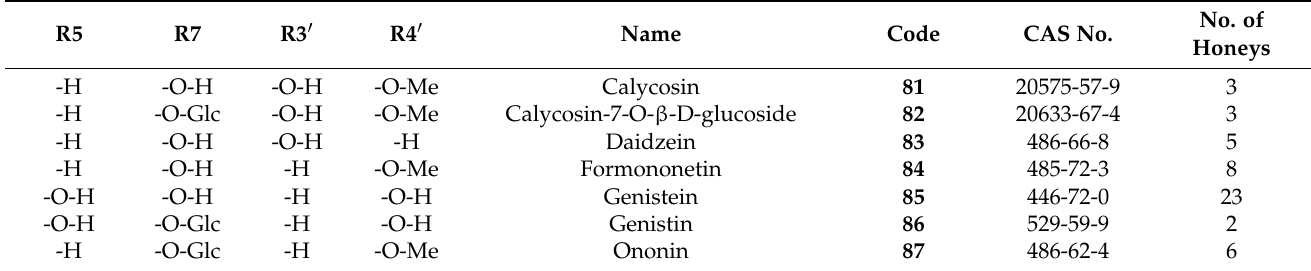
Figure 12. Basic isoflavonoid structure (see 81 – 87 in Table 7). Table 7. Isoflavonoids reported in honeys (see Figure 12 for general structure).